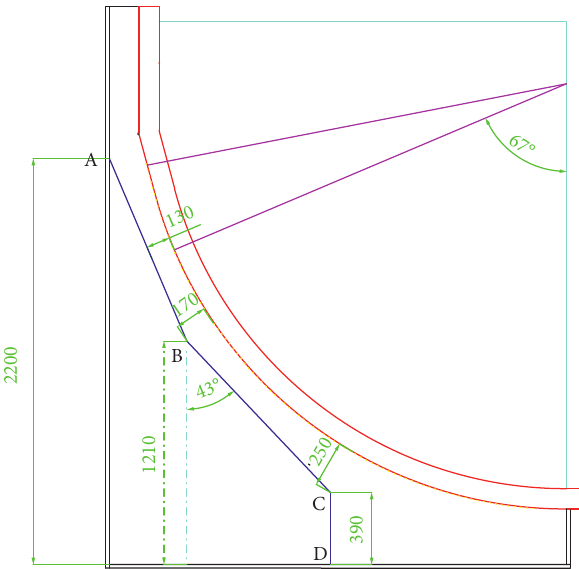
Figure 10: The schematic diagram with the optimized flow channel of the test section.